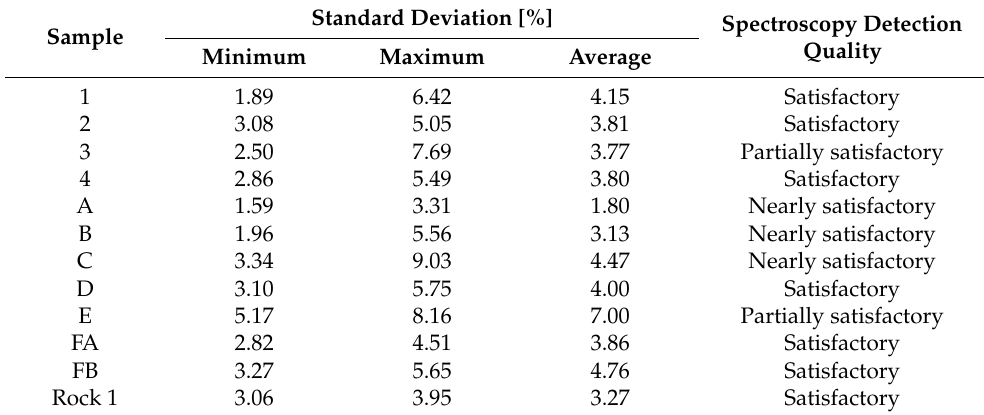
Table 2. Sample measurements—data and detection quality.